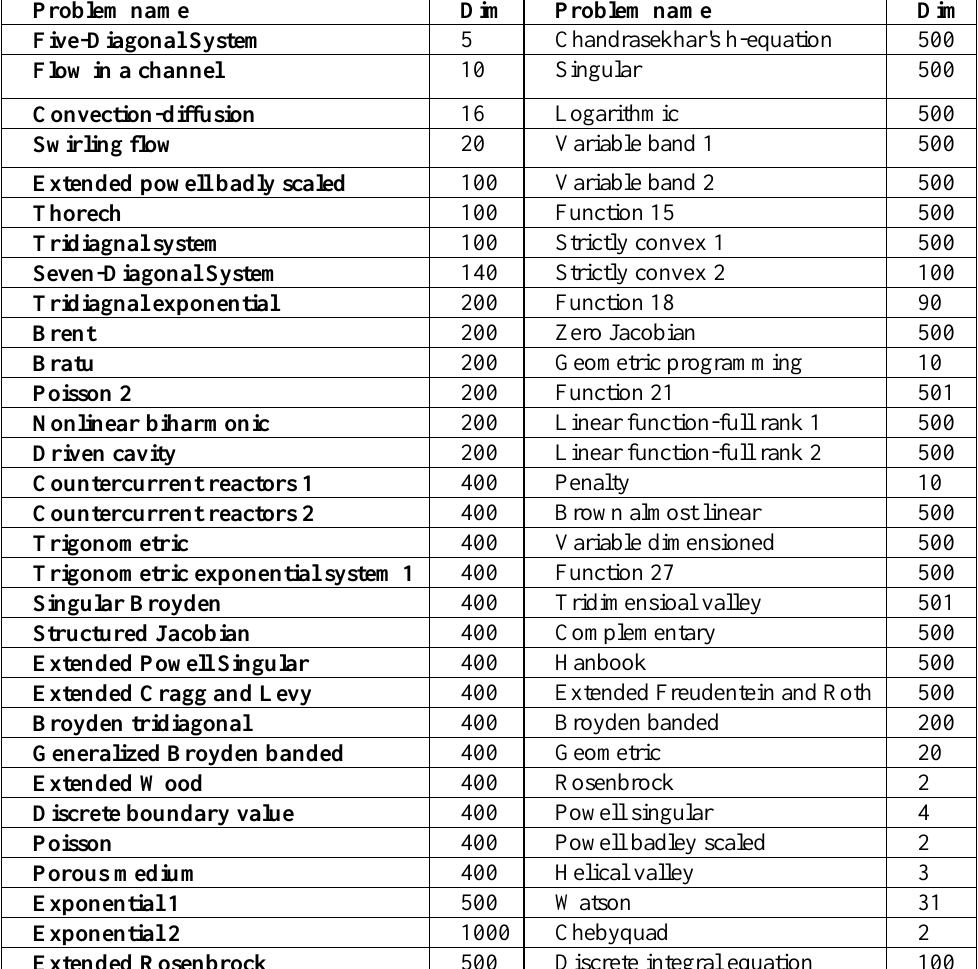
Table 1. List of test